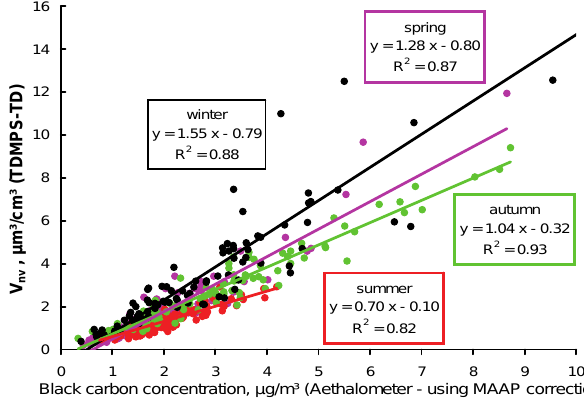
Fig. 10. Black carbon mass concentration (aethalometer) versus the non-volatile particle mass concentration ( D p < 800nm; TDMPS- TD) on the basis of daily